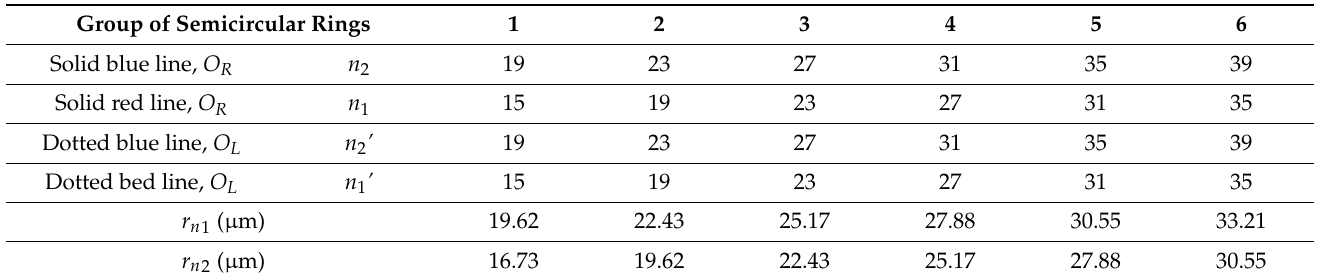
Figure 3. Theory and simulation results of the dual vortices and VBs. ( a ) The metasurface sample of a single group of CSRs with n 2 = n 2 ’ = 19 and n 1 = n 1 ’ = 15. The FDTD intensity pattern ( b ) and the phase map ( c ) of the dual vortices under illumination of LCP, respectively. ( d – f ) Theoretical intensity patterns of I = | E x | 2 + | E y | 2 , | E x | 2 and | E y | 2 of the dual radially polarized VBs. ( g – i ) The intensity patterns of FDTD simulations. The insets are the enlarged views. The overlaid arrows show the schematic polarization states. Table 1. Parameters for the design of metasurface samples with 6 groups of